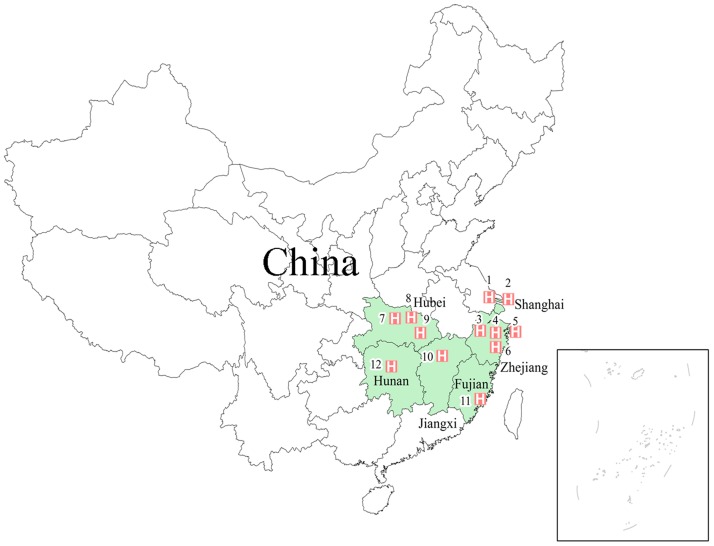
Locations of the 12 sentinel hospitals in eastern China at which respiratory syncytial virus (RSV) patients were treated.The red numbers indicate the locations of the surveillance sites. A total of 12 sentinel hospitals located in six provinces were enrolled in the final RSV infection analysis. 1). Children's Hospital of Shanghai, Shanghai Jiao Tong University; 2). Children’s Hospital of Fudan University; 3). Huzhou Central Hospital, Zhejiang Province; 4). The First Affiliated Hospital, School of Medicine, Zhejiang University; 5). The Children’s Hospital, School of Medicine, Zhejiang University; 6). Zhejiang Provincial Center for Disease Control and Prevention; 7). Renmin Hospital of Wuhan University; 8). Tongji Hospital, Tongji Medical College, Huazhong University of Science & Technology; 9). Wuhan Women and Children Medical Care Center, Hubei Province; 10). Jiangxi Provincial Children’s Hospital; 11). Maternal and Children's Health Hospital of Fujian Province; 12). Hunan Provincial People’s Hospital.